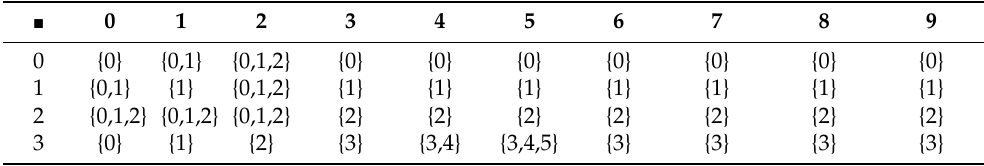
Table 11. The binary hypergroupoid ( P , (cid:4)